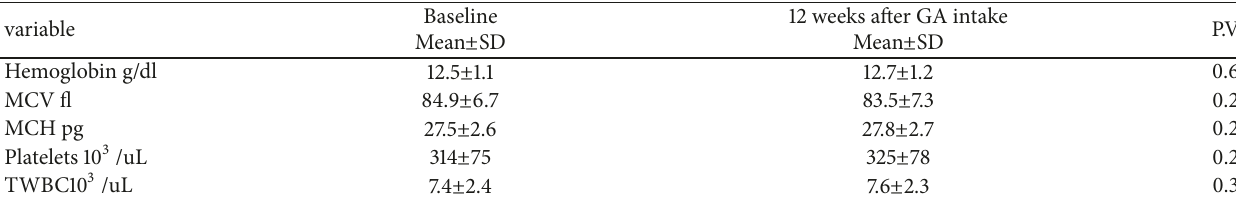
Table 2: Comparison between the mean of pre- and post-intervention values of hematological indices.